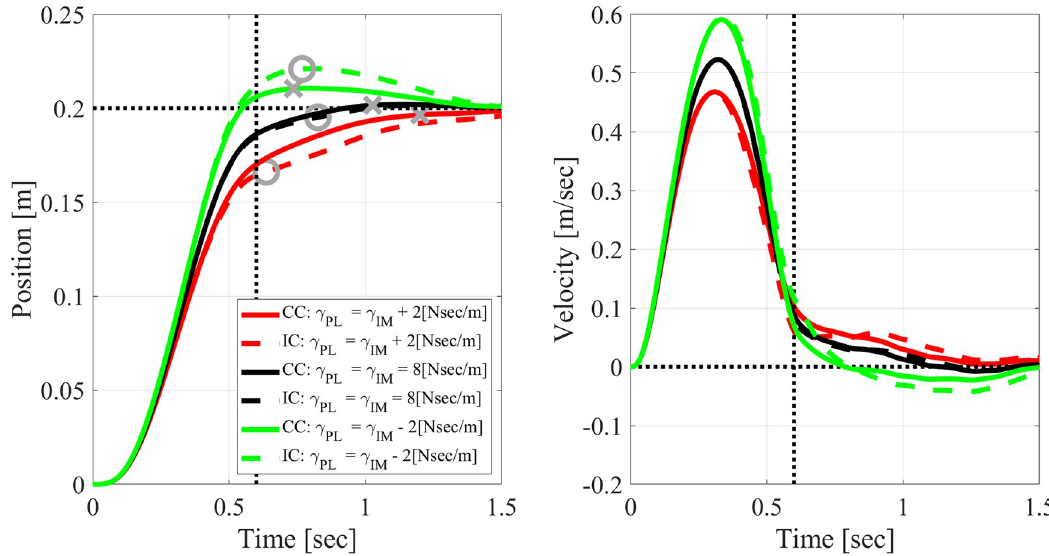
Fig 7. Effect of inaccurately modeled damping ratio on simulated reaching movements with measurement delay of τ = 0.15 [sec]. Solid: CC. Dashed: periodic IC with h = 0.2[ sec ]. The damping ratio of the plant, γ PL , is either smaller (green), equal (black) or larger (red) than the damping ratio of the internal model, γ = 8[ Nsec / m ].Left: position. Right: velocity. Dashed lines, circles and IM crosses as in Fig 6.